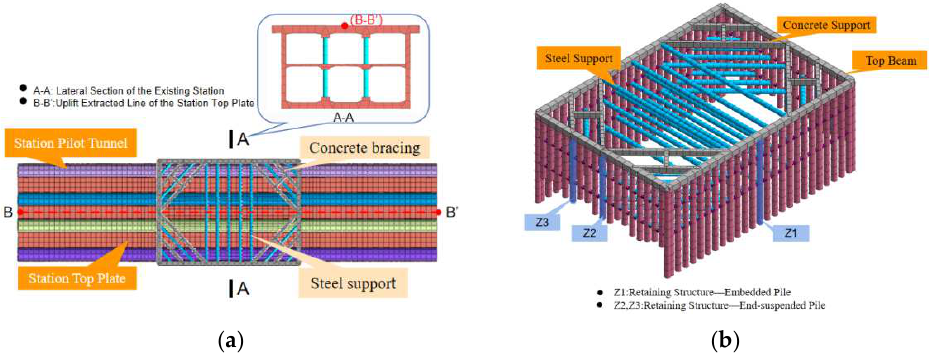
Figure 4. Schematic diagram of retaining structure and existing station. ( a ) Top view of existing station; ( b ) schematic diagram of retaining structure. Table 1. Mechanical parameters of soil.